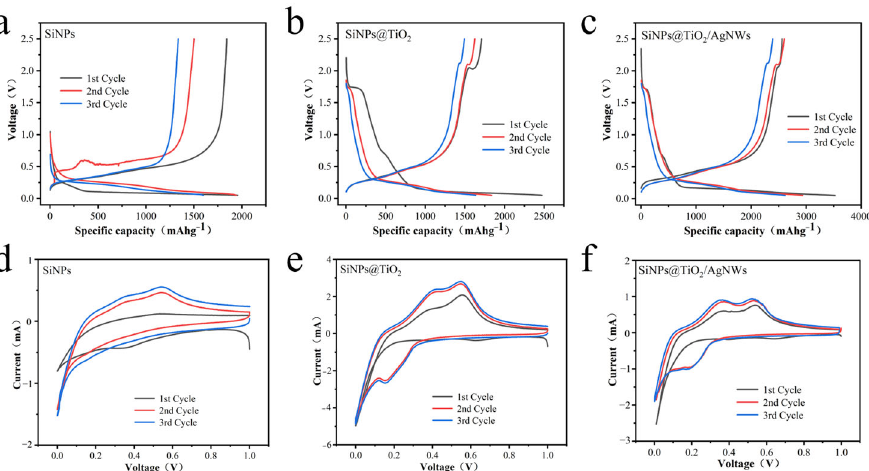
Figure 5. Charge/discharge curves and cyclic voltammetry curves of different anode materials ( a , d ) SiNPs, ( b , e ) SiNPs@TiO 2 , and ( c , f ) SiNPs@TiO 2 /AgNWs. ( a , d ) SiNPs, ( b , e ) SiNPs@TiO 2 , and ( c , f ) SiNPs@TiO 2